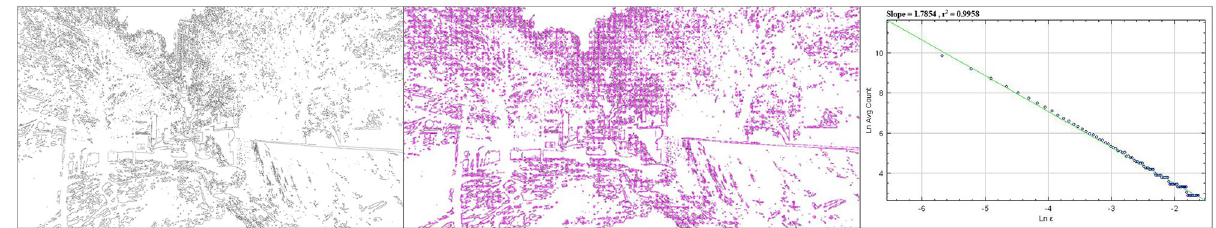
Fig 2. (1) Fractal dimension calculation steps in ImageJ Fractlac. (2) box counting image presentation (3) best fit line with the